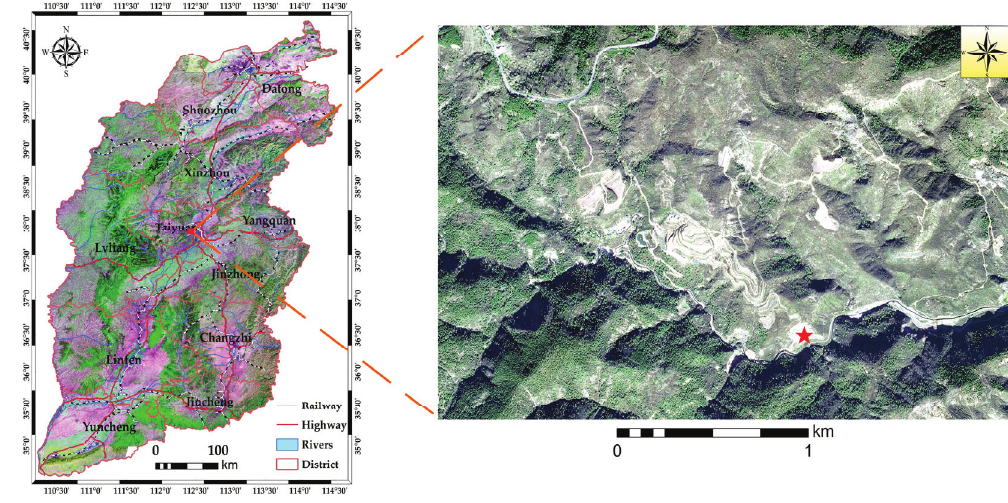
Figure 1. Geographical map of the study area. (cid:3)